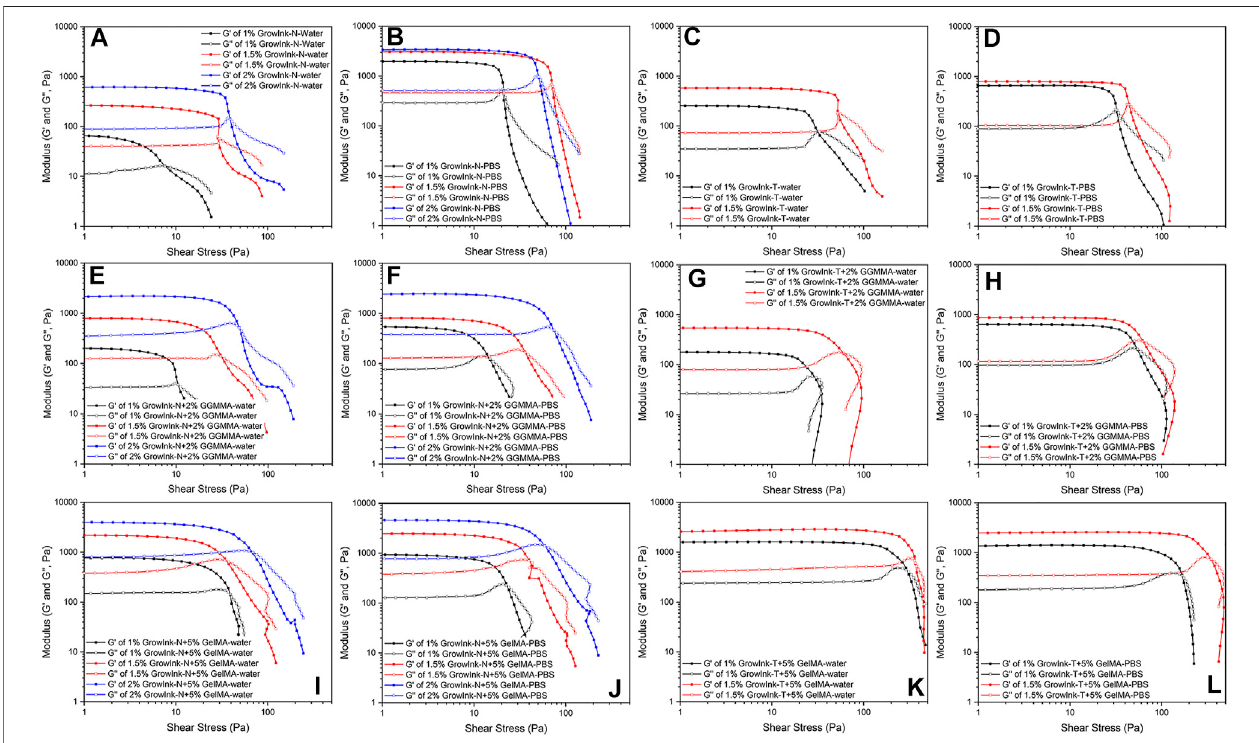
FIGURE 3 | Amplitude sweep of formulated inks plotted against the shear stress [ (A – D) GrowInk-N and GrowInk-T, (E – H) GGMMA incorporated GrowInk-N and GrowInk-T, and (I – L) GelMA incorporated GrowInk-N – and GrowInk-T – based inks diluted with PBS buffer and water, respectively. Closed symbol: G ’ and open symbol: G ”